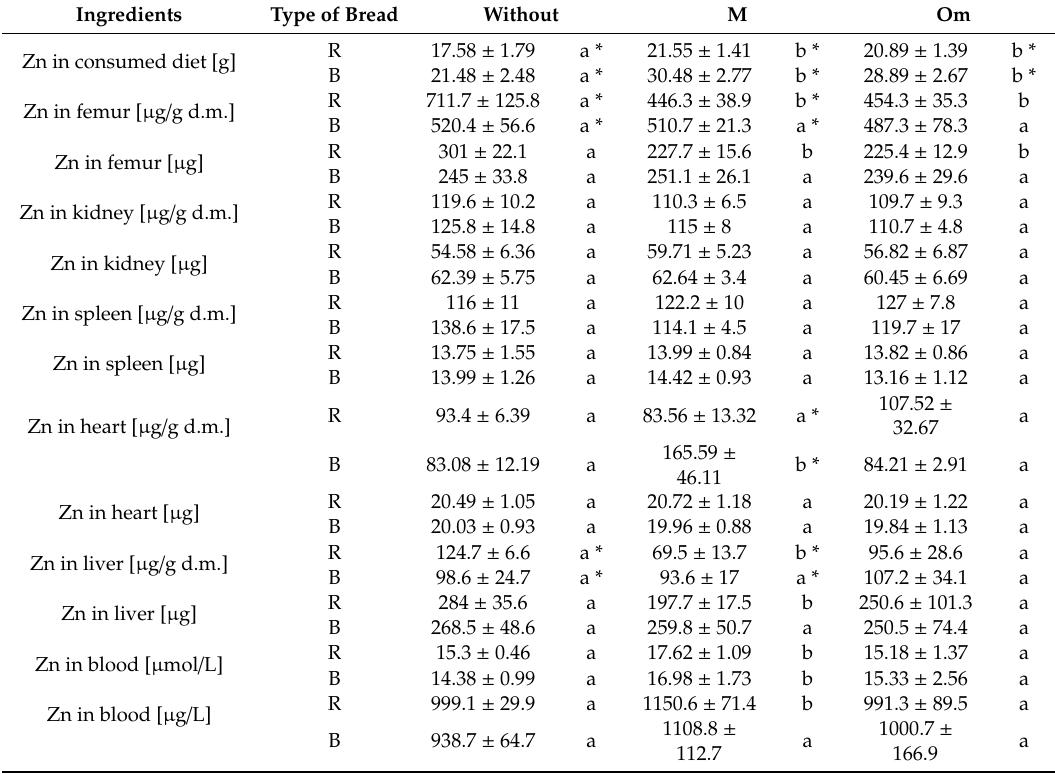
Table 4. Zinc content in